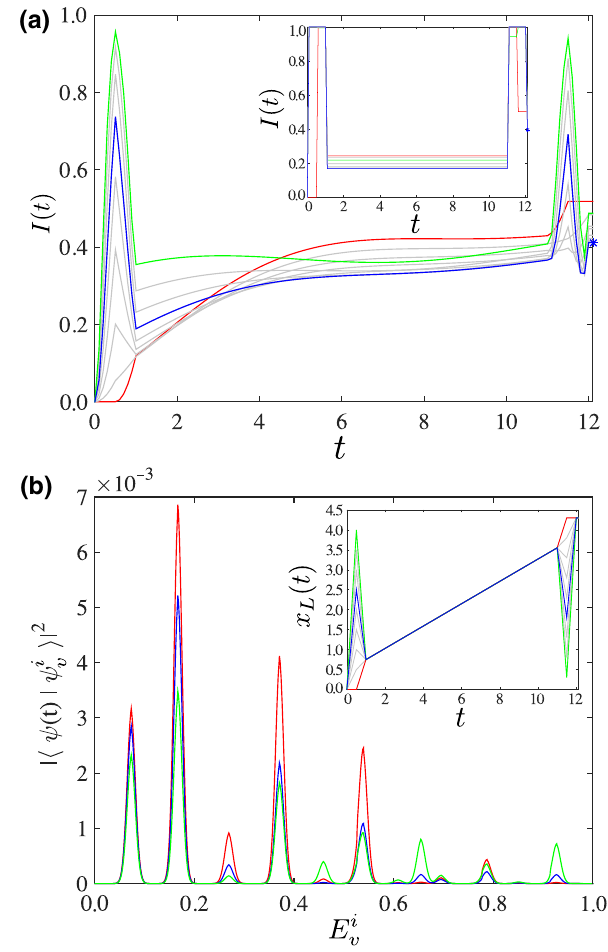
FIG. 6. (a) Instantaneous infidelity I ( t ) with respect to the static (lab) frame ground state (main panel) and moving-frame ground state (inset) as a function of the protocol time t for various dressed jumps in regime (I), which are depicted by the differ- ent colors (red, blue, green, gray) and shown in the inset of (b). The optimal dressed jump (blue) has the minimum infidelity with the moving-frame ground state and becomes the strategy with the minimum static frame infidelity after about t ≈ 4. (b) The time-evolved state | ψ( t ) (cid:4) expanded in the single and two particle excitations | ψ i v (cid:4) of the moving-frame basis with energies E i v at t = T / 2 for a forward jump (red), an optimal dressed jump (blue), and nonoptimal dressed jump (green) for regime (I) as given in the inset. The occupation probabilities ( δ functions) are convo- luted for visualization purposes. The forward jump strategy (red) occupies the excitations close to the bottom of the band in the moving frame ( E i v ≈ 0.08 ) more compared to the dressed jumps (blue and green). In this figure all times are in units of 1 /ω